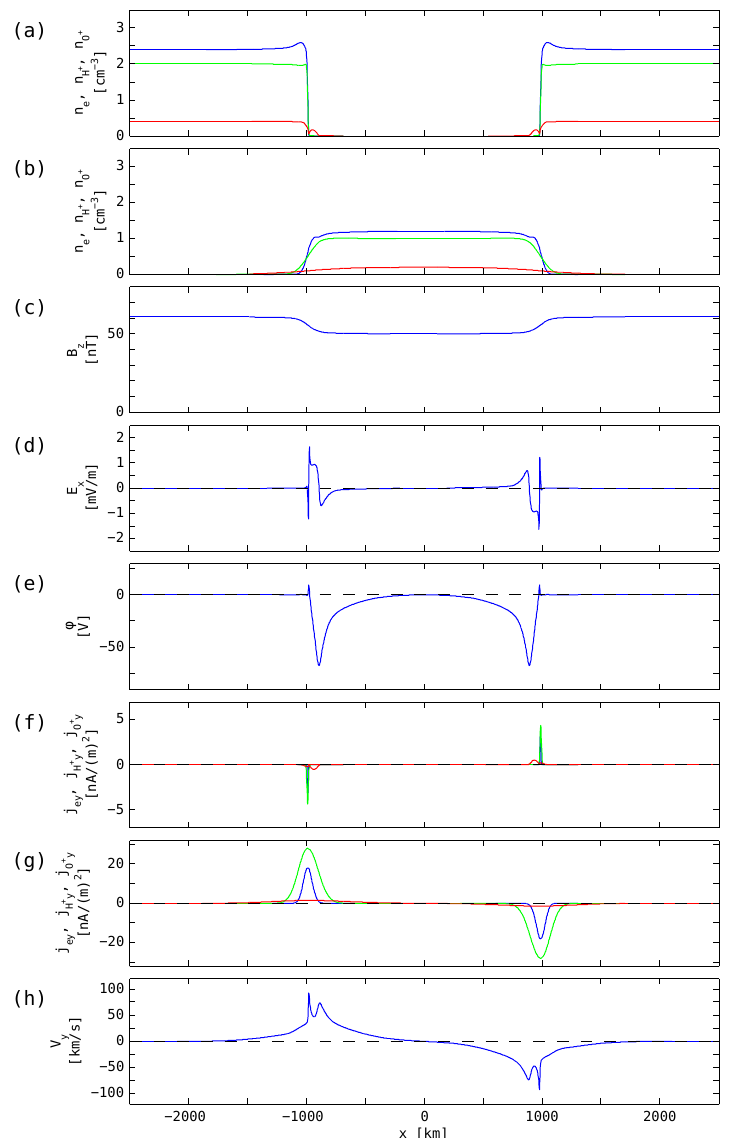
Fig. 4. Plasma and field structure of a 2000km-wide plasma slab embedded in a uniform background. The plasma parameters are given in Table 1. There is no cross-field flow at the slab centre, V 0 y = 0, and the electric potential boundary conditions are zero, φ( ±∞ ) = 0. The panels show (a) the densities of the background populations, blue for the electrons, green for the H + ions, red for the O + ions; (b) the density profiles of the slab populations, blue for the electrons, green for H + , red for O + ; (c) the magnetic field magnitude; (d) the electric field; (e) the electric potential; (f) the partial currents along y of the background populations, with the same colour code as before; (g) the partial currents along y of the slab populations; and (h) the plasma bulk velocity along y